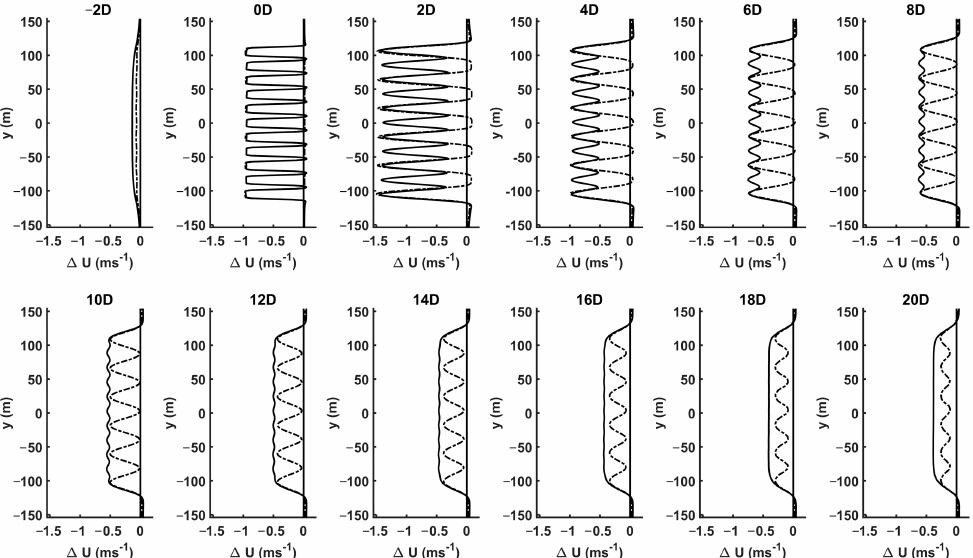
Figure 6. Horizontal distribution of the velocity deficit (velocity magnitude with turbines minus velocity magnitude without turbines) at the hub height (15 m above the flat seabed) at different streamwise positions from the fence of devices. Continuous and dashed lines correspond to a lateral spacing of 1.5 D and 3 D , respectively. The velocities have been extracted, at peak flood tide, from the simulation with AD with K = 3 ( a = 0.33 and 0.34 for ∆ = 1.5 D and ∆ = 3 D , respectively). The orientation of the axis y differs from that retained in Figure 1.